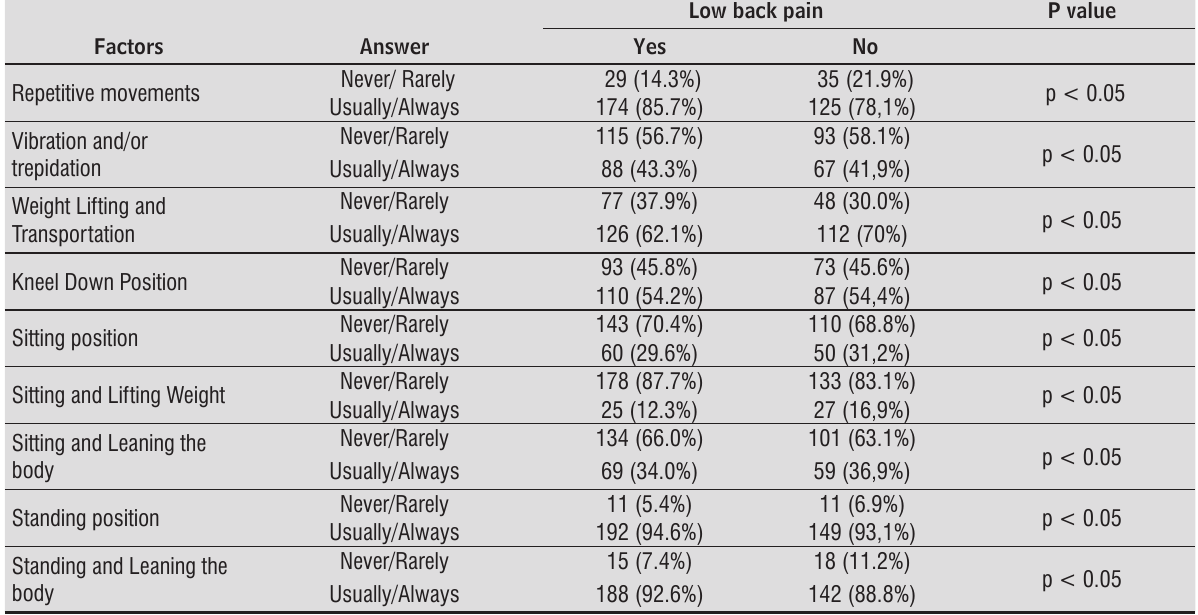
Table 4 - Bivariate analysis among ergonomic variables and low back pain in elderly people